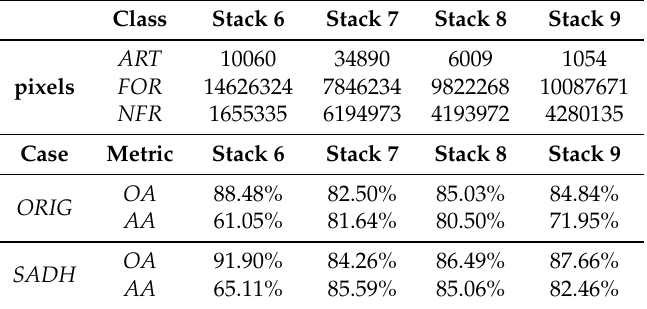
Table 4. Overall accuracy (OA) and average accuracy (AA) for the four swaths in Figure 4. Each swath is associated to a stack, according to the enumeration in Table 2.